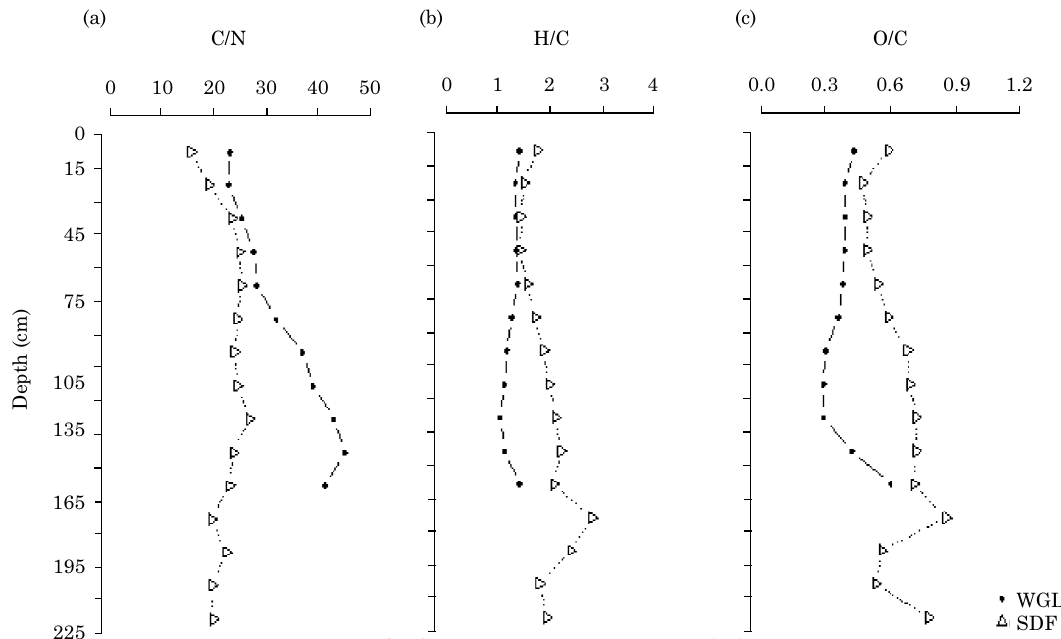
Figure 5. Ratios (a) carbon/nitrogen (C/N), (b) hydrogen/carbon (H/C), (c) oxygen/hydrogen (O/H), and (d) oxygen/carbon (O/C) in depth in core samples under wet grassland (WGL) and semi-deciduous forest (SDF) from the peat in the headwaters of the Córrego Cachoeira dos